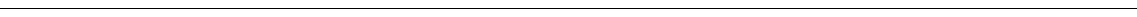
Fig. 2 Substrate-dependent localization of proteins. Dual-color reconstructions of a Lyp1-L-YPet/Pil1-mKate2 and b Can1-L-YPet/Pil-mKate2 with and without lysine plus arginine in the growth medium, indicated as +KR and − KR, respectively. Wide- fi eld images are depicted for clarity. All the scale bars represent 2 µ m. c Cross-correlation of Pil1-mKate2 and Sur7-YPet. Panels: images were treated with a discoidal-averaging fi lter to better illustrate the localizations; the co-localization analysis was done with the raw diffraction-limited images. Wide- fi eld images are depicted for clarity. d Number of localizations per cell of Lyp1 and Can1 with and without lysine plus arginine with error bars representing the standard deviation. e – h show cross-correlation of Pil1-mKate2 vs. proteins tagged with L-YPet; the left graph of each panel shows the correlation coef fi cients over distance for the various proteins with error bars representing standard error of the mean; the right graph of each panel shows the histograms of the probability distributions of single-cell cross- correlations. e Sur7 (blue; n = 118); f Lyp1 before addition of lysine plus arginine (green; n = 104), 40 min after the addition of lysine plus arginine (magenta; n = 138), and 120 min after the addition (blue; n = 108); g Can1 before addition of lysine plus arginine (red; n = 101), 40 min after the addition of lysine plus arginine (blue; n = 113) and 120 min after the addition (tan; n = 116); h Nha1 (light blue; n = 69). i , j Histograms showing the distance of Can1 molecules to the closest eisosome. Black lines indicate probability of fi nding an eisosomes at a discrete distance. i Can1 without arginine ( n = 35); j Can1 with arginine ( n = 47); n represents number of cells